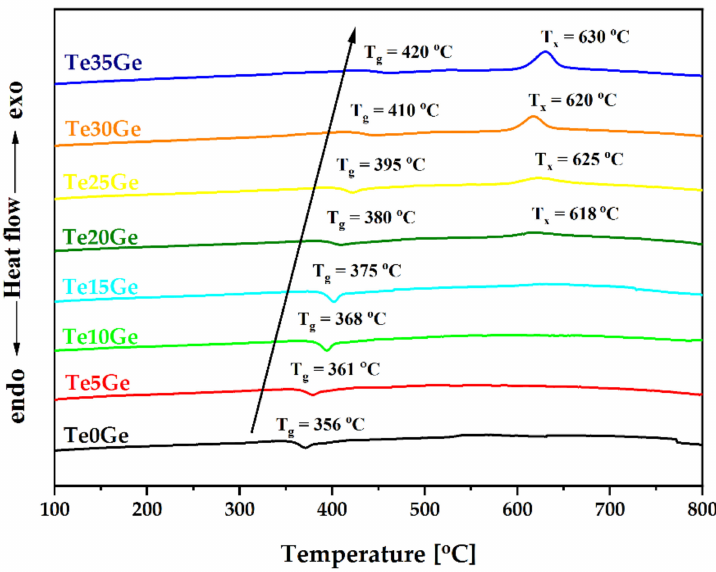
Figure 2. DSC curves of Eu 3+ -doped glasses with various TeO 2 /GeO 2 molar